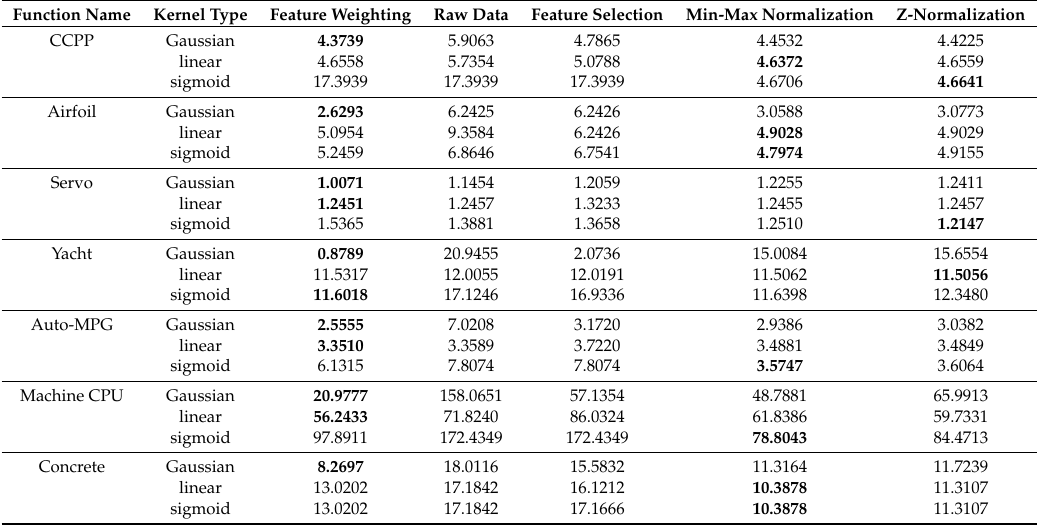
Table 6. Performance comparison of SVR modeling for the UCI